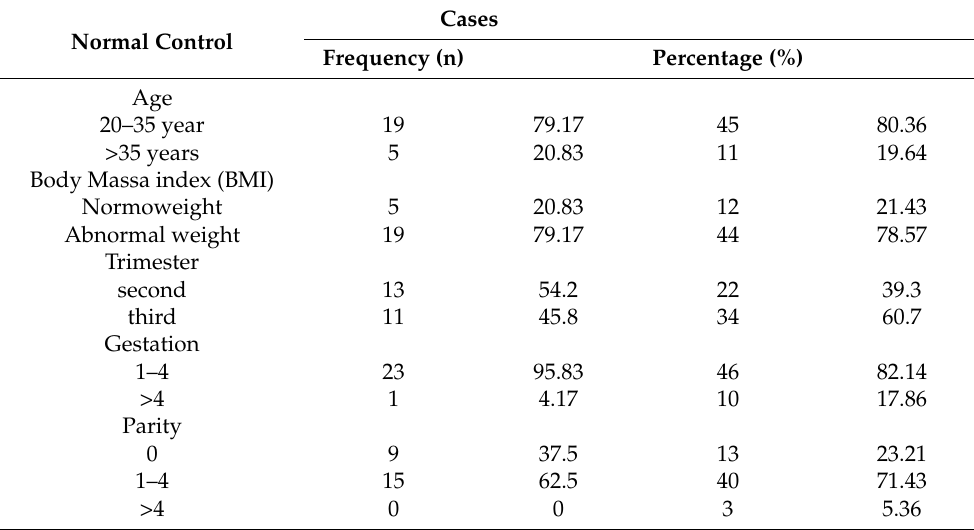
Table 2. General characteristics of research